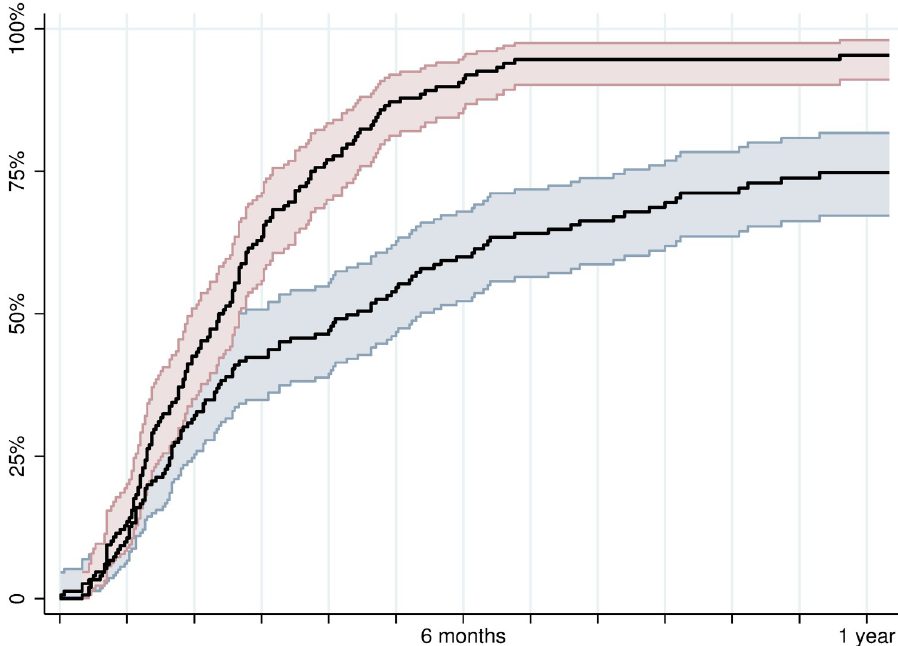
Fig 2. Time to hepatitis C treatment initiation presented with Kaplan–Meier plot. Red line/area indicates proportion of participants in integrated arm initiation treatment with confidence intervals. Blue dashed line/area indicates proportion of participants in standard treatment arm initiation